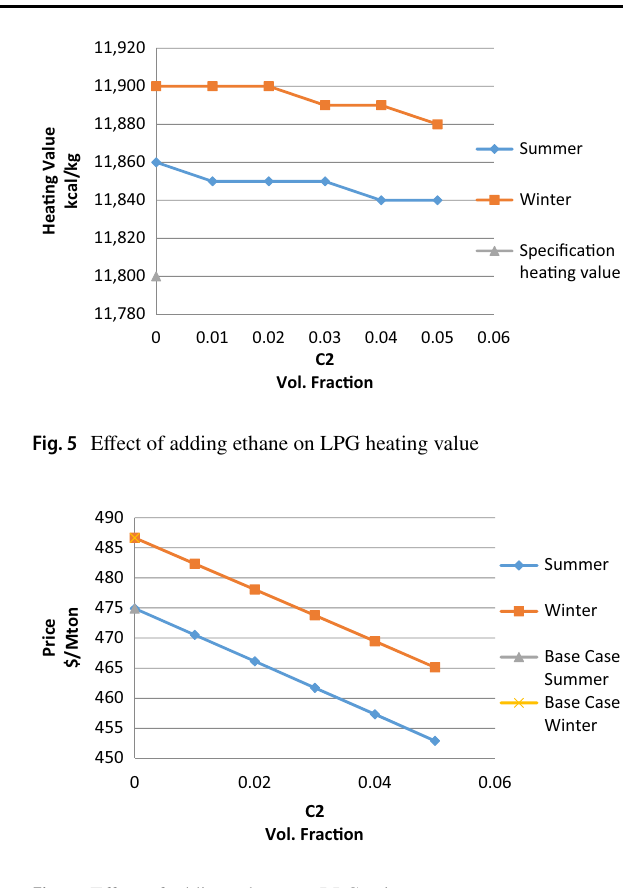
Fig. 6 Effect of adding ethane on LPG